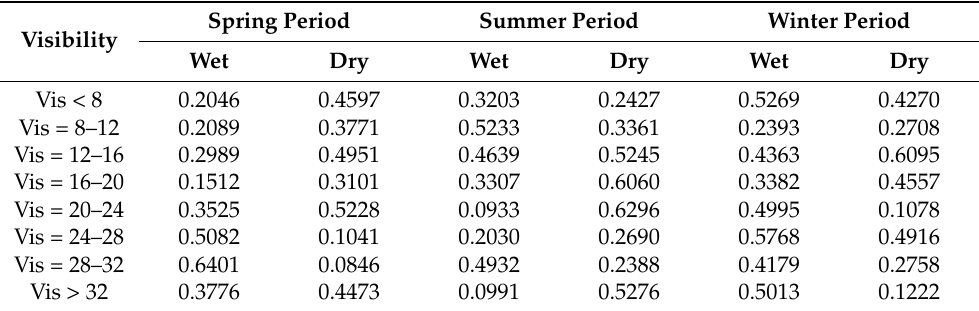
Table A3. Results of K-S calculations (probability p) showing the agreement of empirical and theoretical distributions describing the number of days with visibility in the appropriate range for precipitation and rain days for spring, summer and winter seasons.